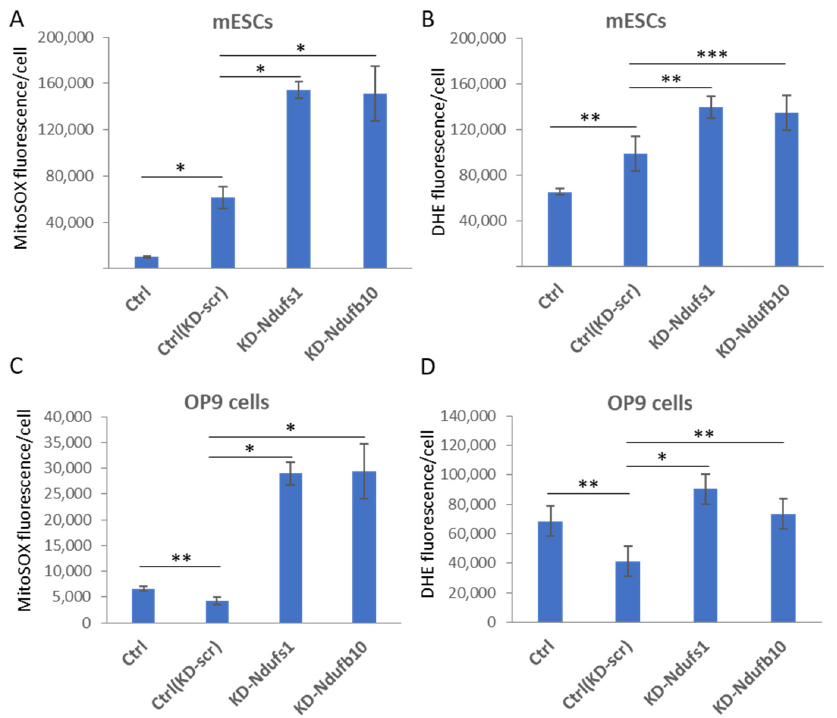
Figure 1. Inactivation of Complex I (CI) of mitochondrial ETC leads to an increased ROS production in pluripotent and somatic cells. shRNA-mediated knockdown (KD) of Ndufs1 or Ndufb10 mRNA elevates mitochondrial superoxide anion ( A , C ) and total ROS ( B , D ) production in mouse ESCs ( A , B ) and the mouse mesenchymal stem cell line OP9 ( C , D ). Control shRNA (KD-Scr) decreases ROS levels in OP9 cells ( C , D ), whereas it augments ROS levels in ESCs ( A , B ). Y -axis represents mean fluorescence of MitoSOX-red ( A , C ) and DHE staining ( B , D ) per cell ± standard deviations ( ± SD), n = 3, * p < 0.001, ** p < 0.01, *** p <